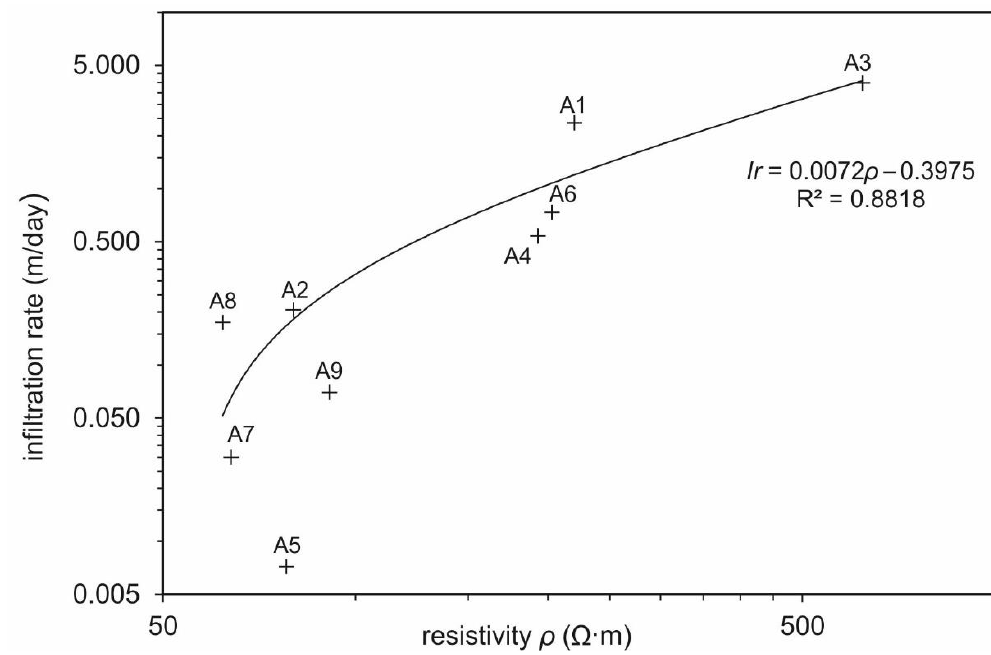
Figure 8. The empirical relationship between electrical resistivity (ρ) and infiltration rate derived from double-ring infiltration tests (Cubeta de Sant Andreu basin).